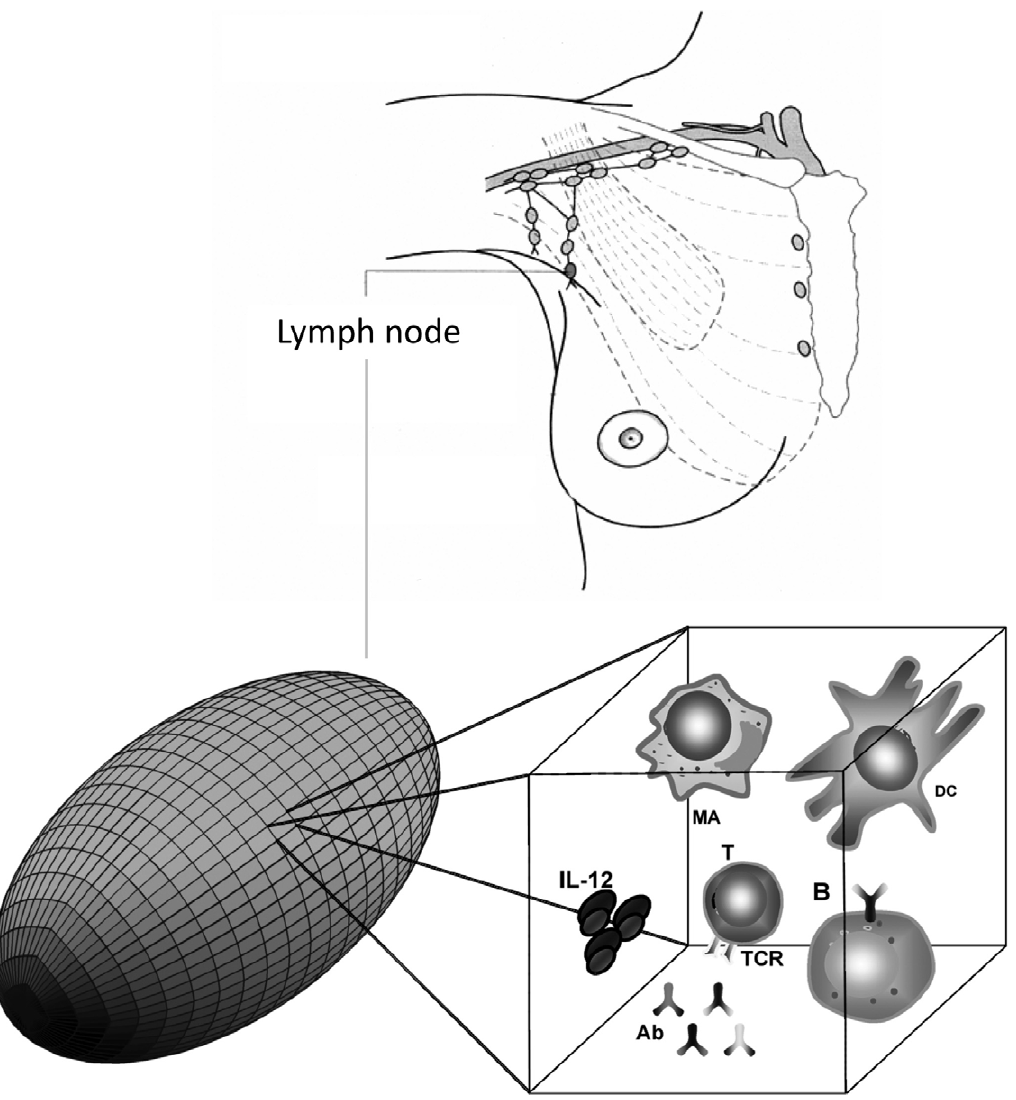
Figure 4. Simulation space. The ellipsoid lattice resemble the typical shape of a lymph node. Entities interact within voxels. Typical simulations consist of 5 m l of volume discretized on 2 7 voxels and populated by about 2 : 10 4 cells.